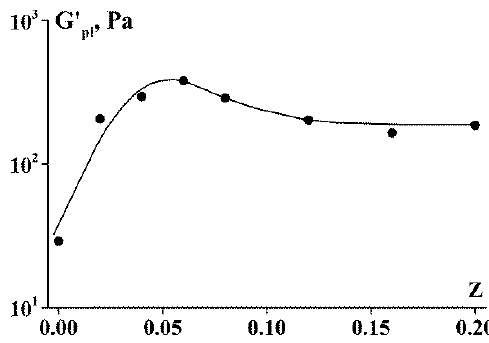
Polymers 2020 , 12 , x FOR PEER REVIEW 15 of 18 Figure 13. Storage modulus dependency on Z. Figure 13. Storage modulus dependency on Z.